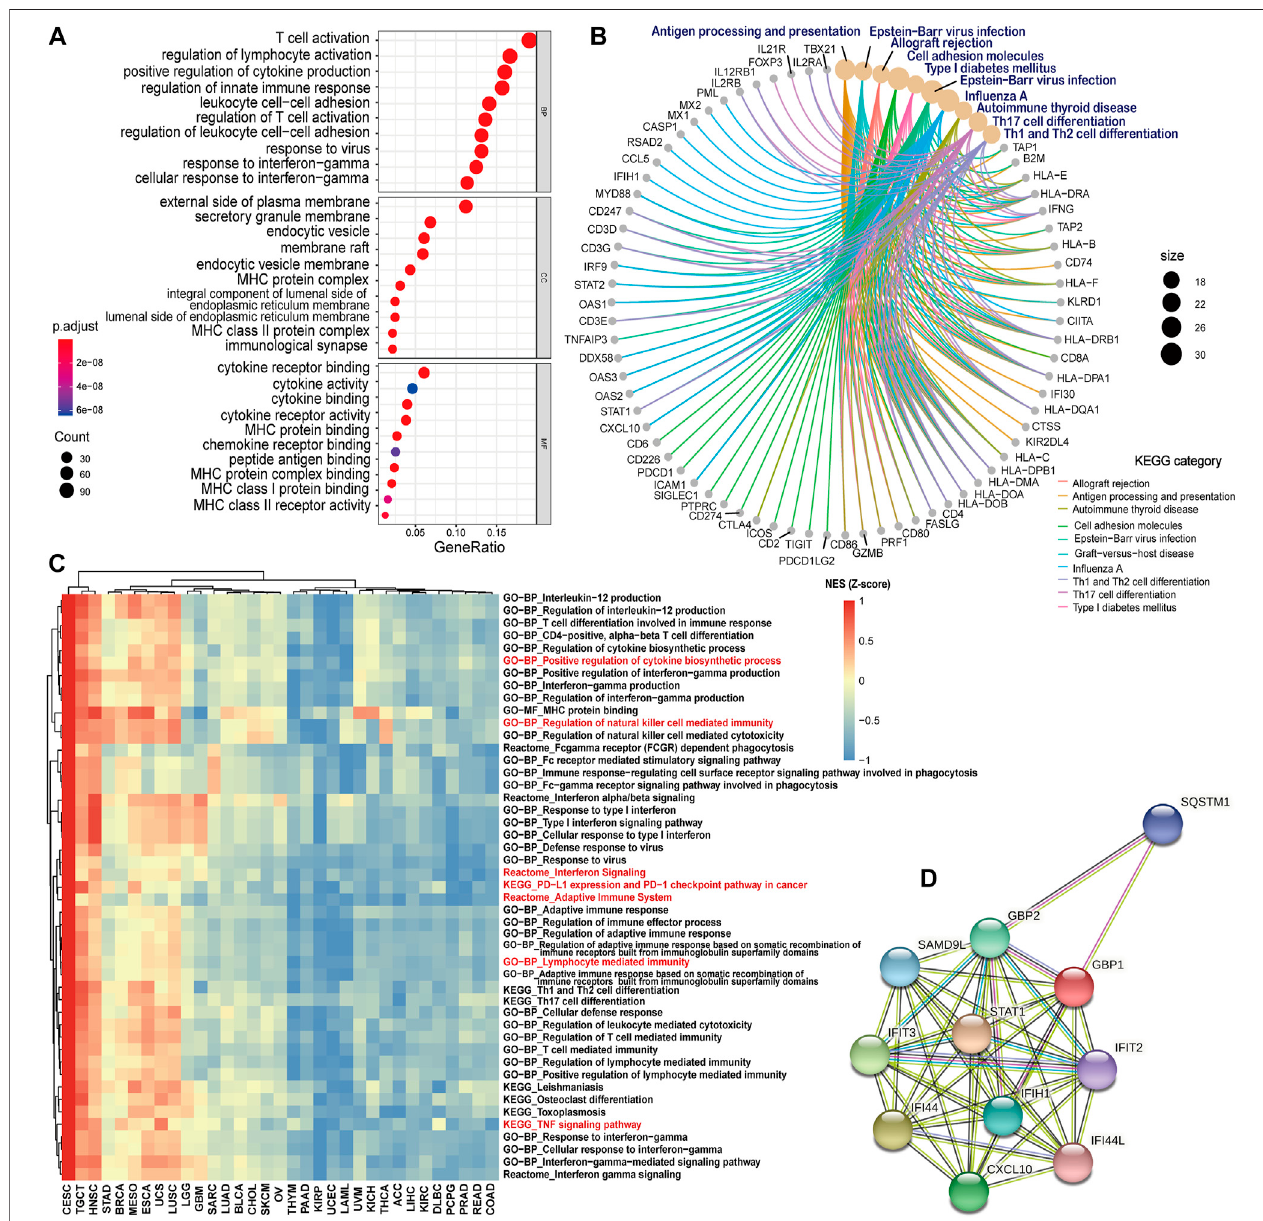
FIGURE4| GBP1-relatedgeneandproteinenrichmentanalysis. (A) Thetop10GOenrichmentsigni fi cancetermsofGBP1-relatedgensinthreefunctionalgroups: biological processes (BP), cell composition (CC), and molecular function (MF). (B) KEGG pathway analysis of GBP1-related genes. (C) Heatmap comparison of signi fi cantGOterms,KEGG,andReactomepathwaysacross33cancertypes.Foreachtermandpathway,thenormalizedenrichmentscores(NES)werenormalizedby Z -score. (D) PPInetworksofGBP1usingtheSTRINGtool.Eachnoderepresentedalltheproteinsproducedbyasingle,protein-codinggenelocus,andeachedge represented the predicted functional